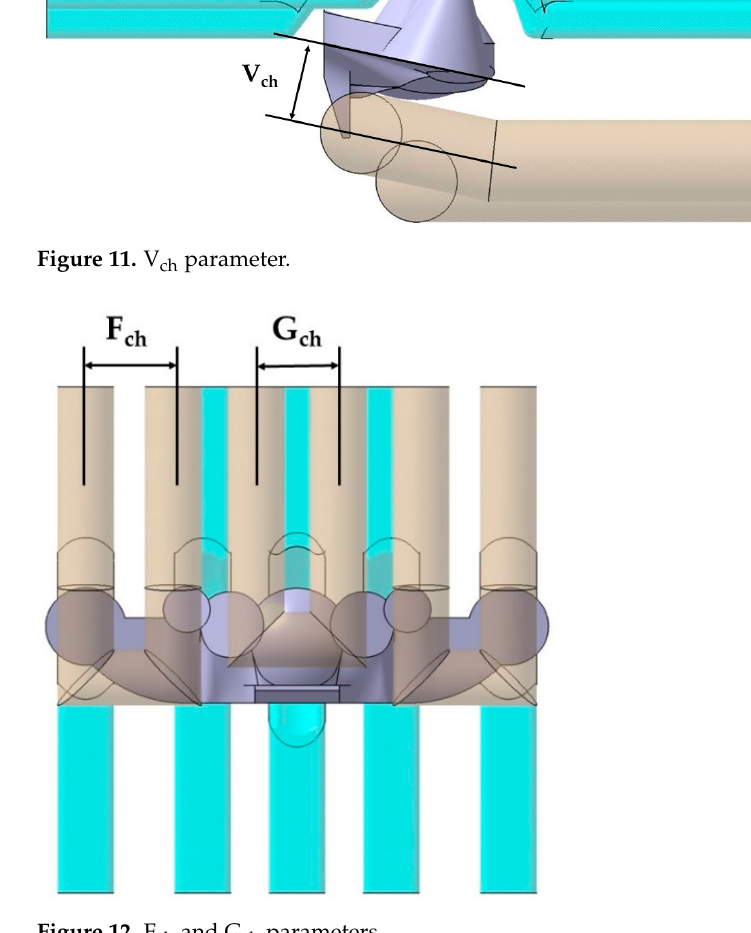
Figure 12. F ch and G ch parameters. Table 3 indicates the dimensional values of the design parameters used in cooling the collimating piece in the cavity plate of the mold. Table 3. Dimensional values of the design parameters used in the cooling of the collimating part in the core of the mold.